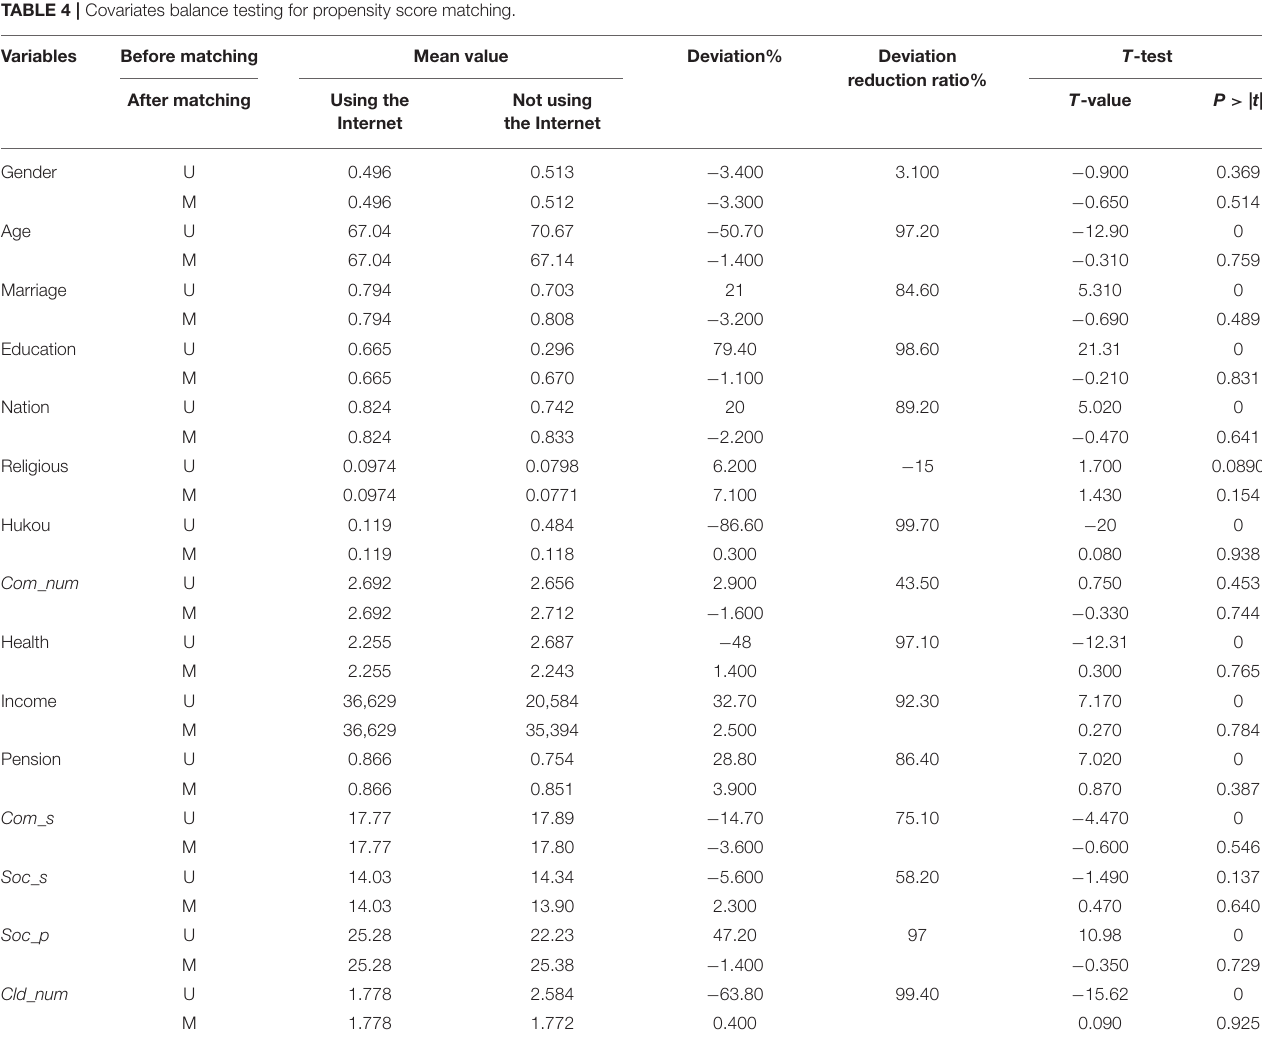
TABLE 4 | Covariates balance testing for propensity score